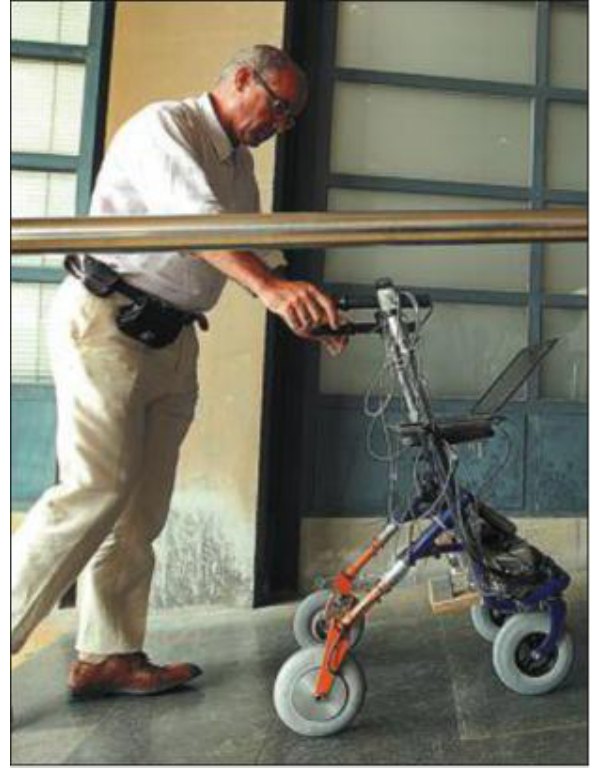
Figure 6. The iWalker prototype (see: